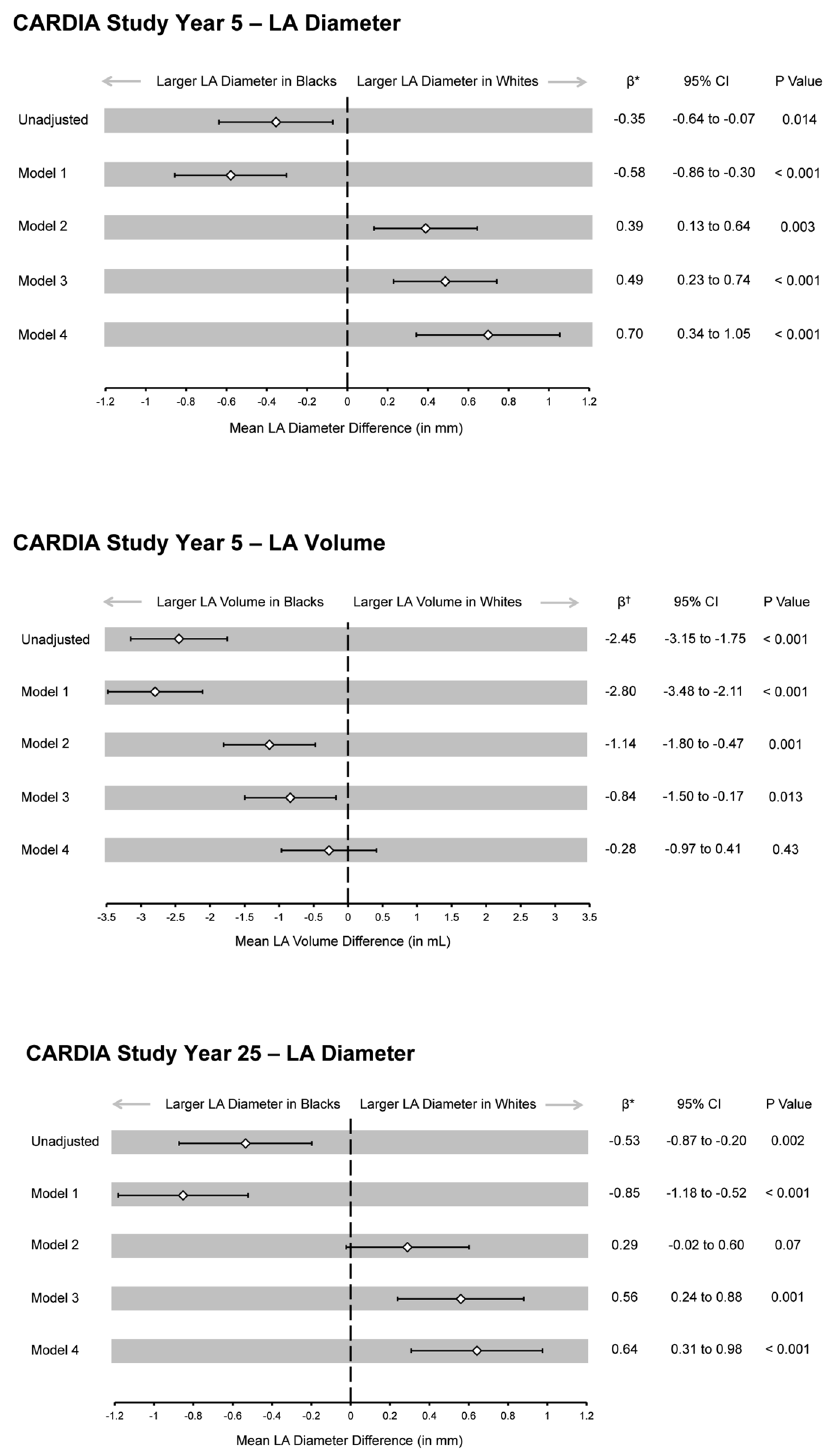
Fig 1. Association Between Race and Left Atrial Size. Model 1: Adjusted for age and gender. Model 2: Adjusted for Model 1 variables, smoking status, alcohol consumption, and body mass index. Model 3: Adjusted for Model 2 variables, heart rate, systolic blood pressure, and antihypertensive treatment. Model 4: Adjusted for Model 3 variables, left ventricular mass, and left ventricular ejection fraction. * Mean millimeter difference in left atrial diameter between Black and White participants. † Mean milliliter difference in left atrial